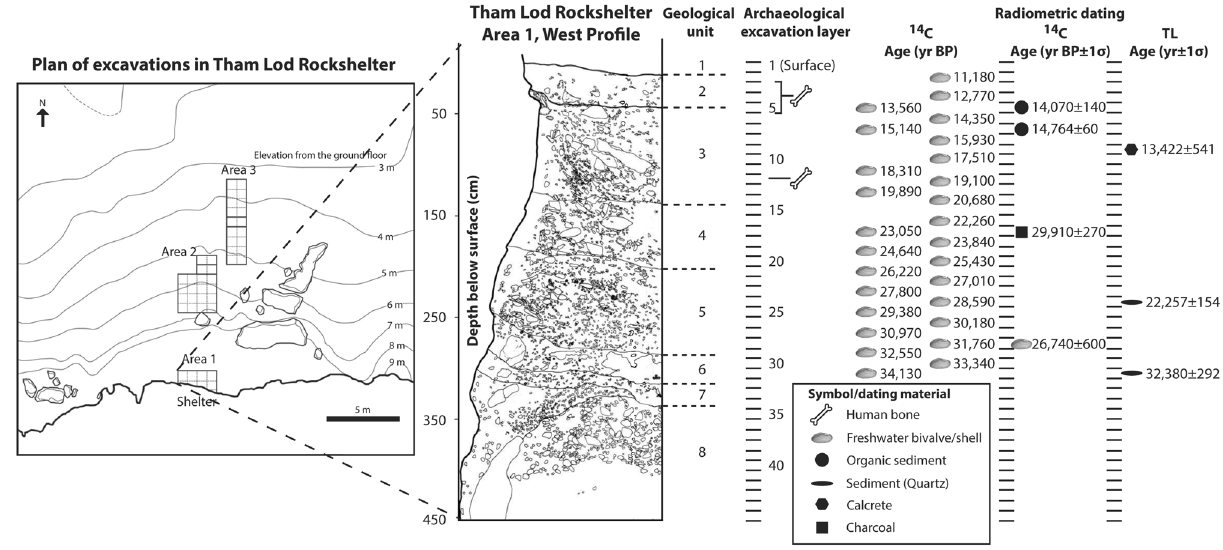
Figure 2. A plan of excavations and stratigraphic profile of the Area 1 of Tham Lod Rockshelter. Ages of each stratigraphic layer obtained from different dating methods and material 14,15,28,29 are plotted together. In this study, all isotope samples of humans and mammals were collected from the layer 1 (top) to 31 (bottom) of the TLR Area 1. The figure was created using Adobe Illustrator CS5 (https:// www. adobe.